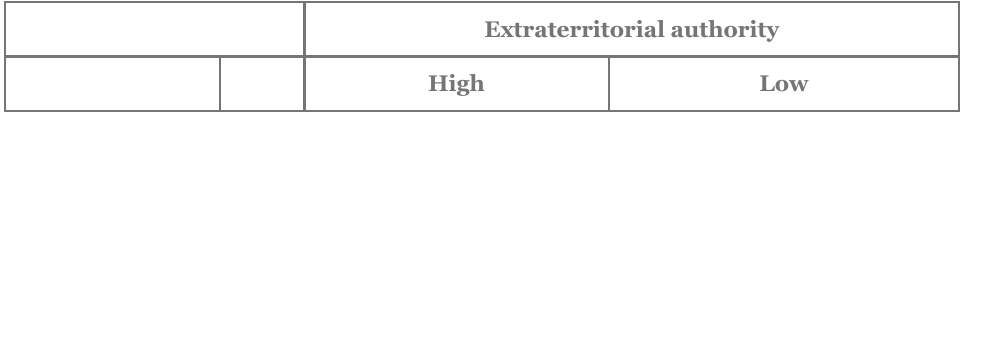
Table 1: Internationalising state power through